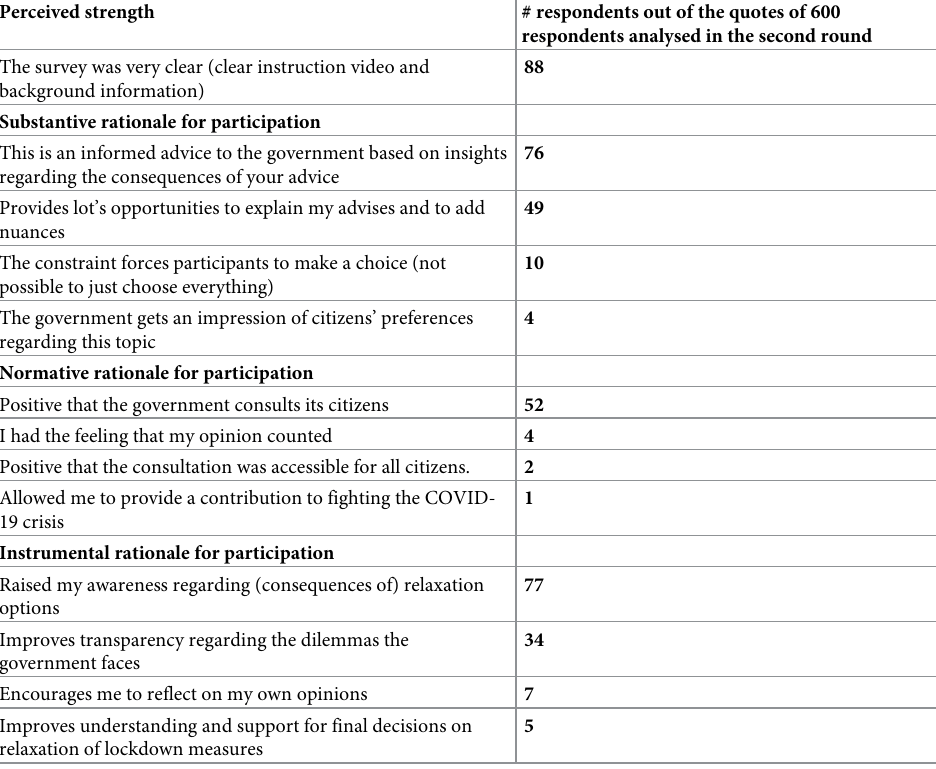
Table 13. Number of times that perceived strengths of the PVE method were